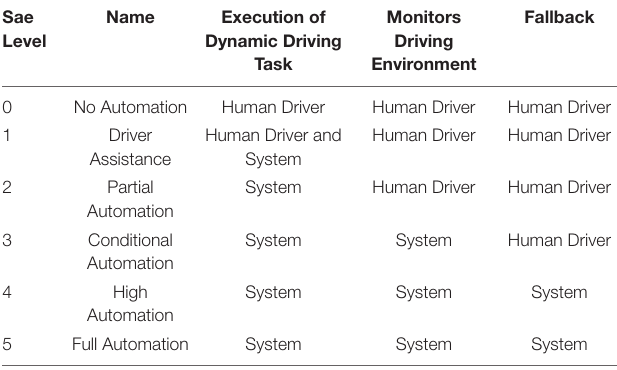
TABLE 1 | Summary of the SAE levels of automation (SAE International,